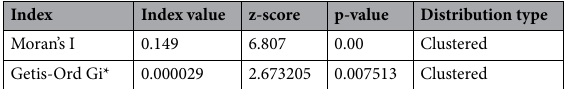
Table 1. Results of the spatial autocorrelation indexes.